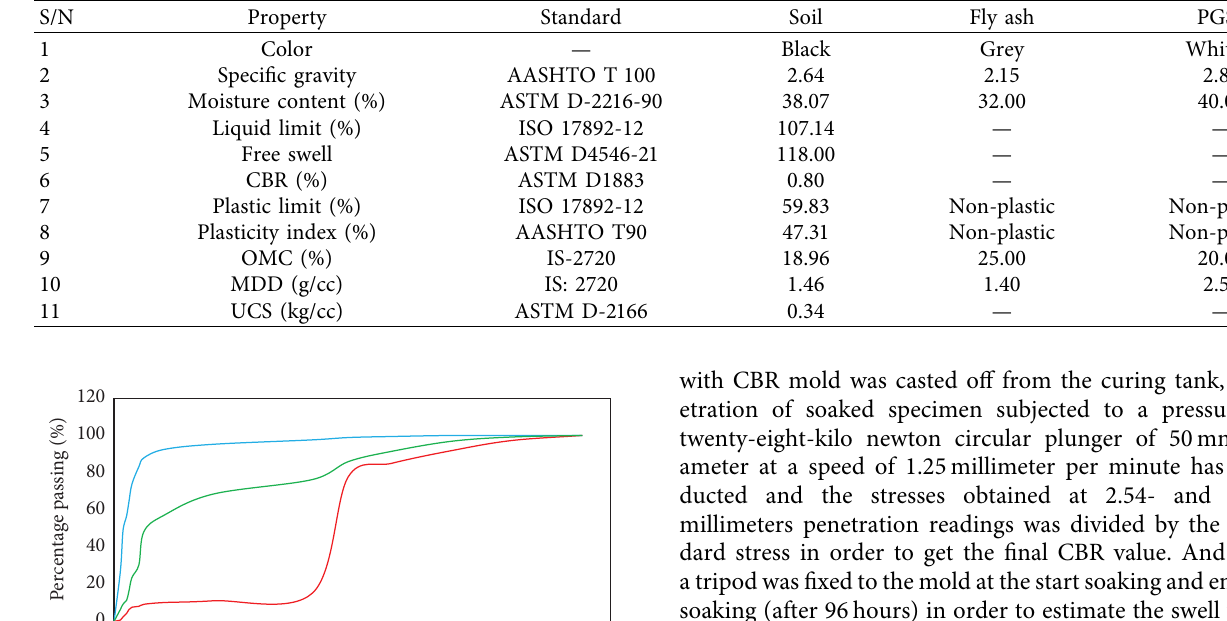
Table 2: Characteristics of materials.